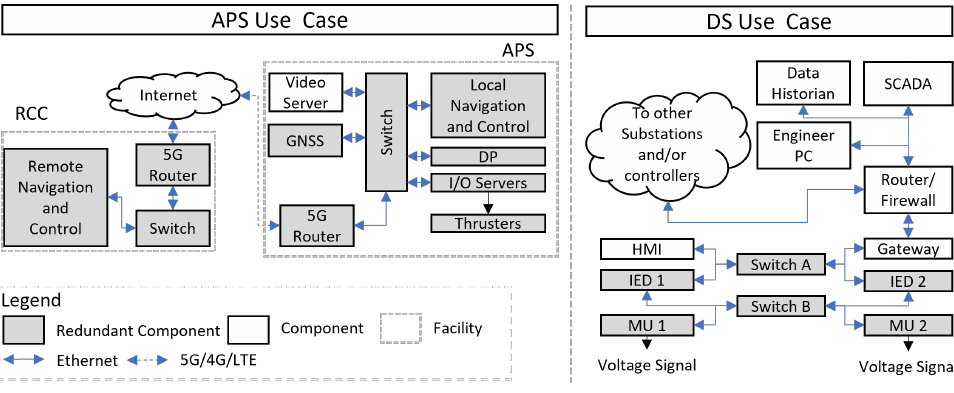
Figure 3. Overview of the APS and DS use